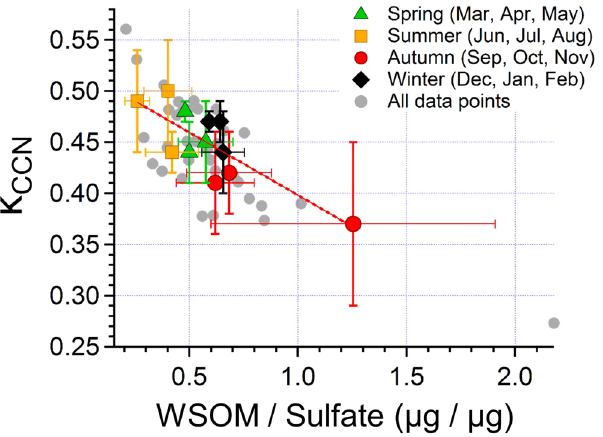
Figure 3. Scatter plot of monthly average κ CCN and the WSOM-to-sulfate ratios with their standard deviations in spring (green triangles), summer (yellow squares), autumn (red circles), and winter (black diamonds) for the year 2013. Individual data are also shown in grey solid circles obtained for each sampling duration of approximately one